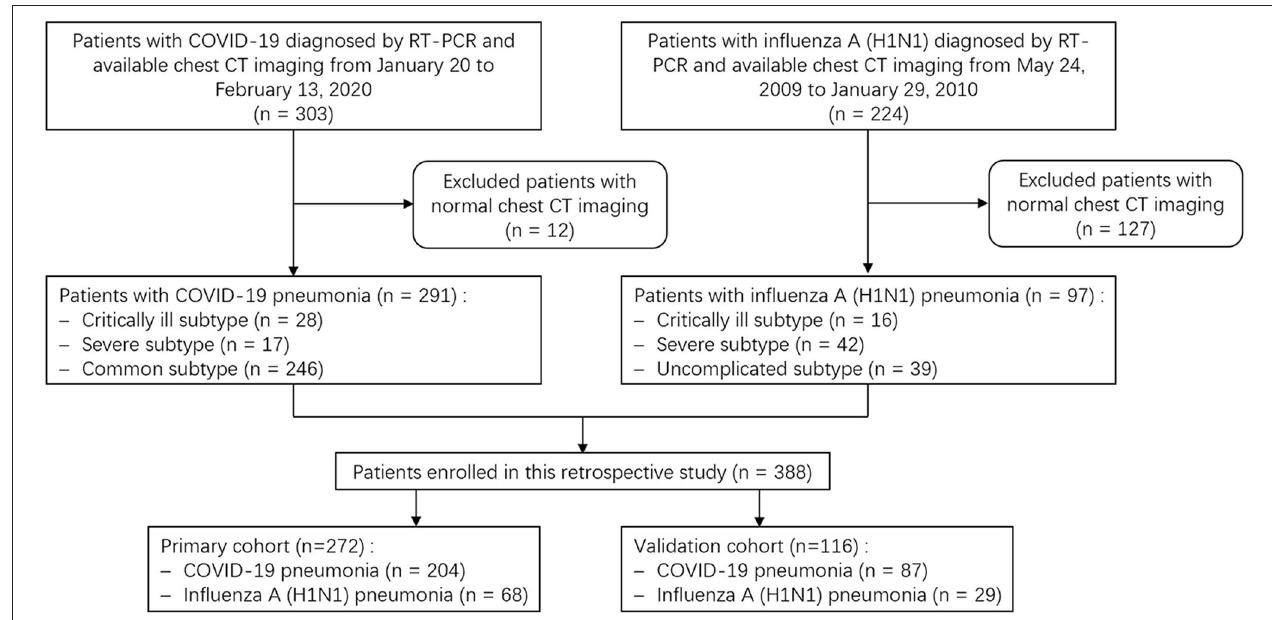
FIGURE 1 | Flow chart shows patient selection, grouping and disease subtypes. COVID-19, coronavirus disease 2019; RT-PCR, real-time Polymerase Chain Reaction.